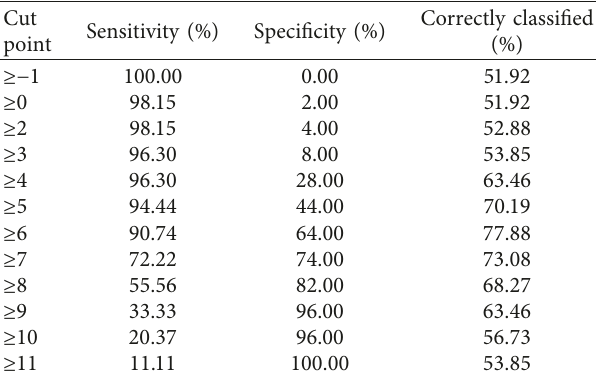
Figure 1: ROC curves from the laroche glaucoma calculator, IOP, CCT, and age. AUC for Laroche calculator � 0.82, AUC for IOP � 0.72, AUC for CCT � 0.53. AUC for age � 0.741. IOP � intraocular pressure, CCT � central corneal thickness. Table 4: Diagnostic accuracy and cut-off for the laroche glaucoma calculator.